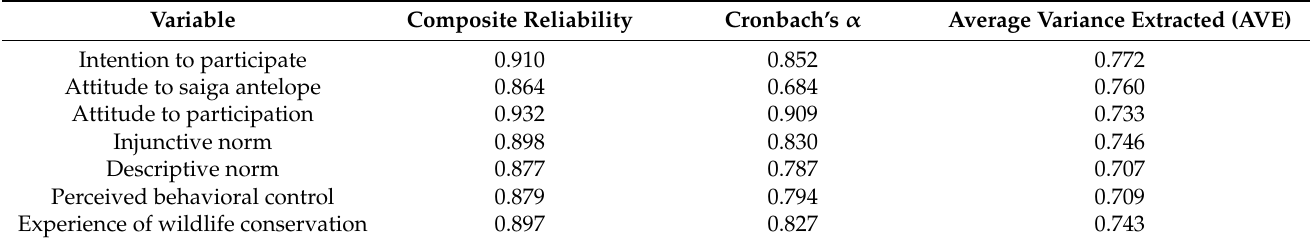
Table 3. Assessment of the measurement